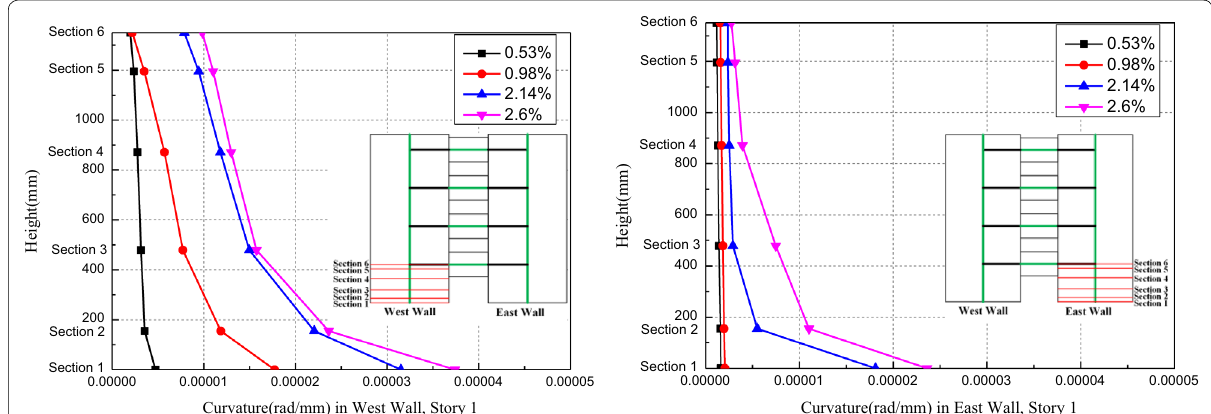
compression wall, =